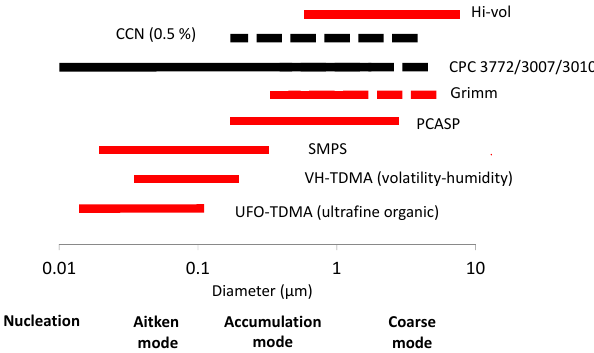
Figure 9. Aerosol characterization during SOAP, indicating size spectral (red) and total count (black) range for each instrument, rel- ative to aerosol size and mode. Ambient RH measurement was used for RH correction of the PCASP, Hi Vol and SMPS, and diffusion driers (Silica Gel) were used on the inlet of the UFO-TDMA and